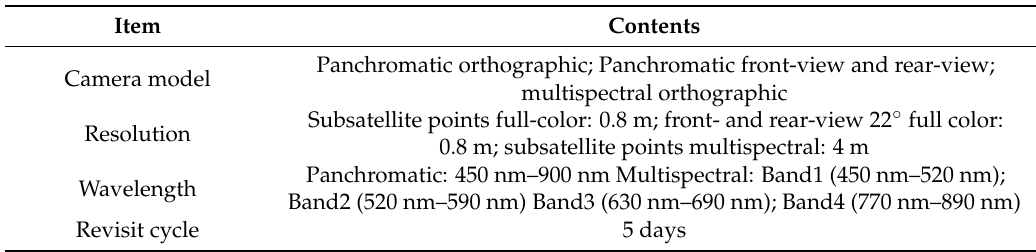
Table 3. GF-2 satellite parameters.